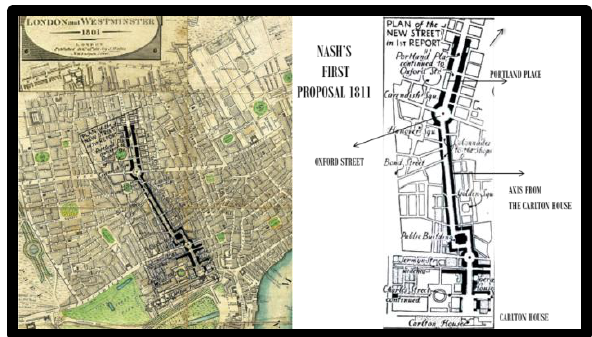
Figure 4 : Nash followed the line of the Portland Place in between the Carlton House repaint by the author .